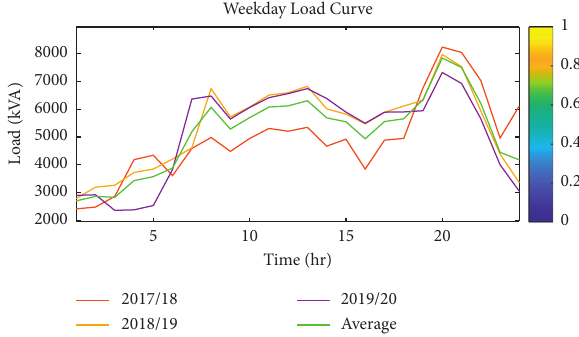
Figure 7: Weekdays hourly average load profile in 2017–2020.